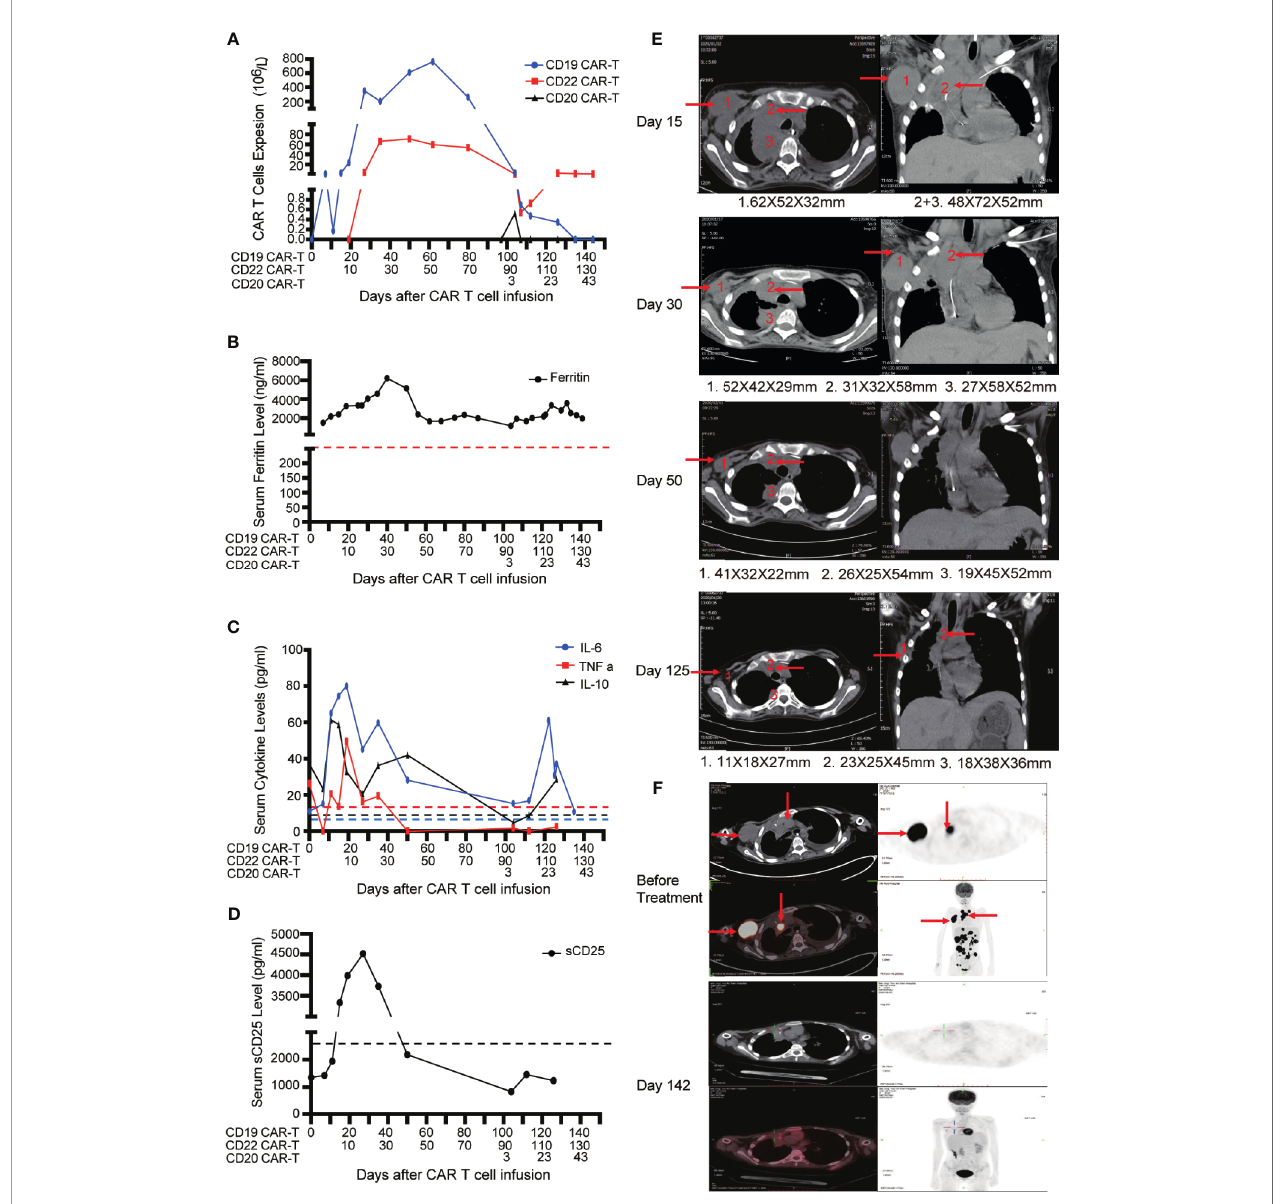
FIGURE 4 | Outcomes of short-interval sequential CAR-T cell treatment in case 2. (A) Monitoring of CD19/CD20/CD22 CAR-T expansions in peripheral blood during sequential CAR-T cell therapies. Detection of serum ferritin level (B) , cytokines (IL-6, TNF- a and IL-10) (C) and serum soluble CD25 levels (D) during sequential CAR-T cell therapies. (E) CT images on the timelines of sequential CAR-T cell infusion. The red arrows indicate tumor sites. (F) Tumor lesions before and after sequential CAR-T cell therapies, detected by